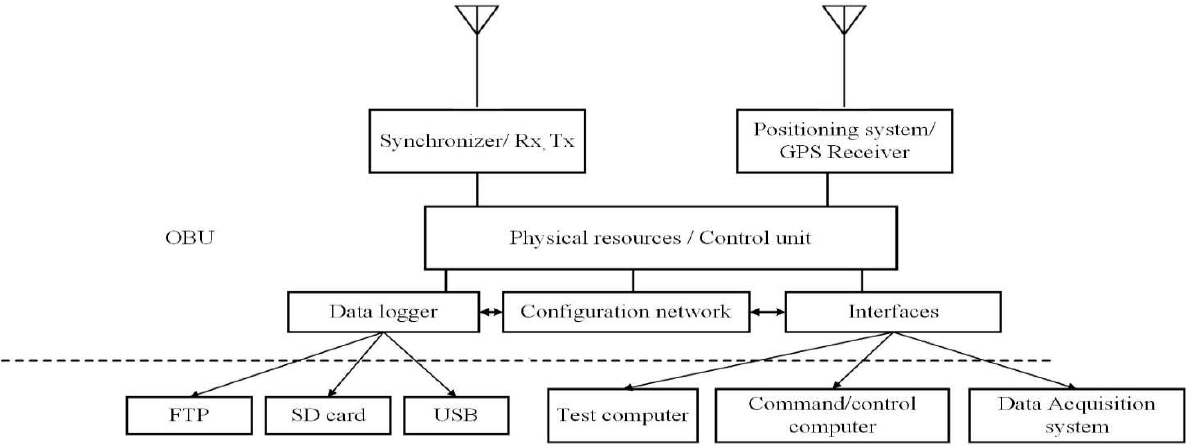
Figure 2. Structure of the OBU.